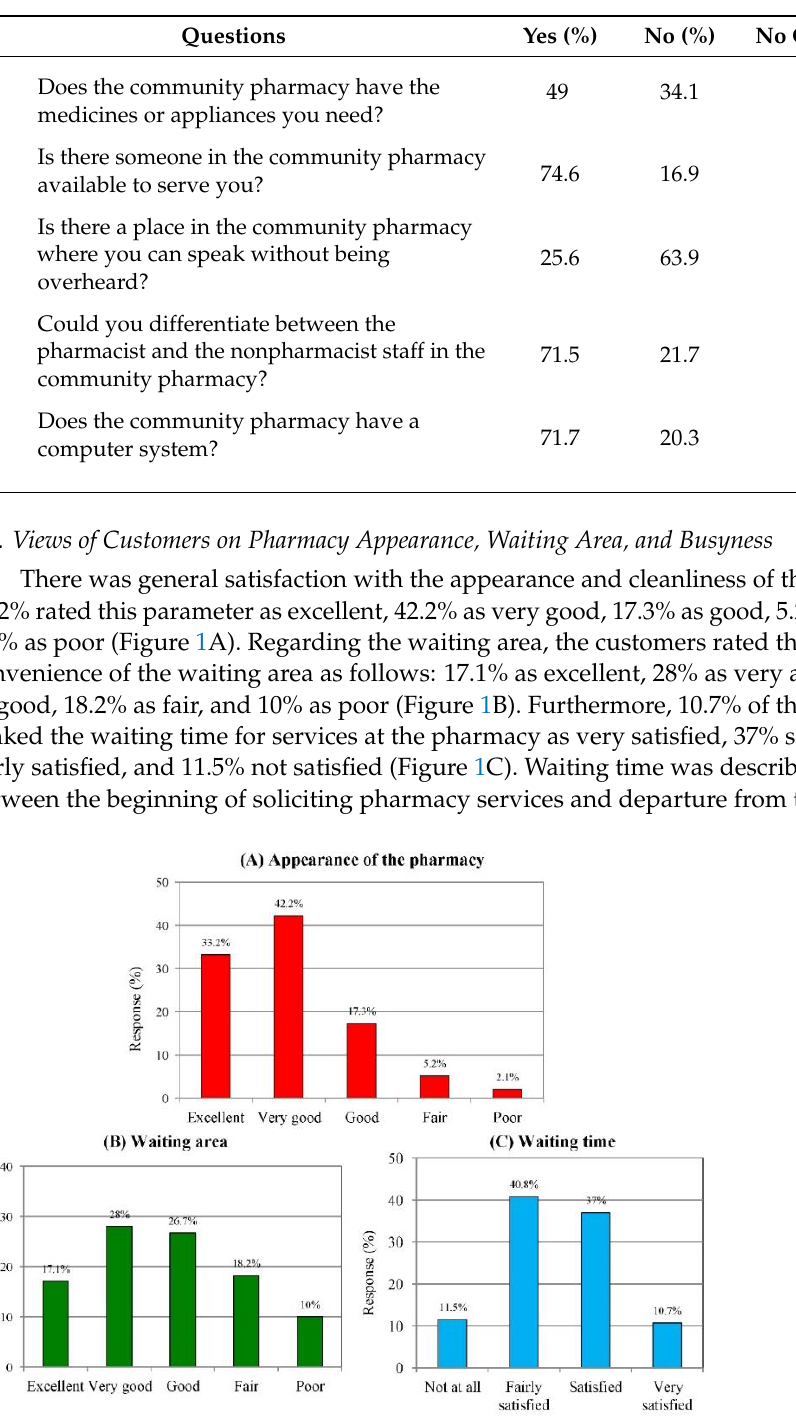
Table 2. Respondents’ Views on the Community Pharmacy.